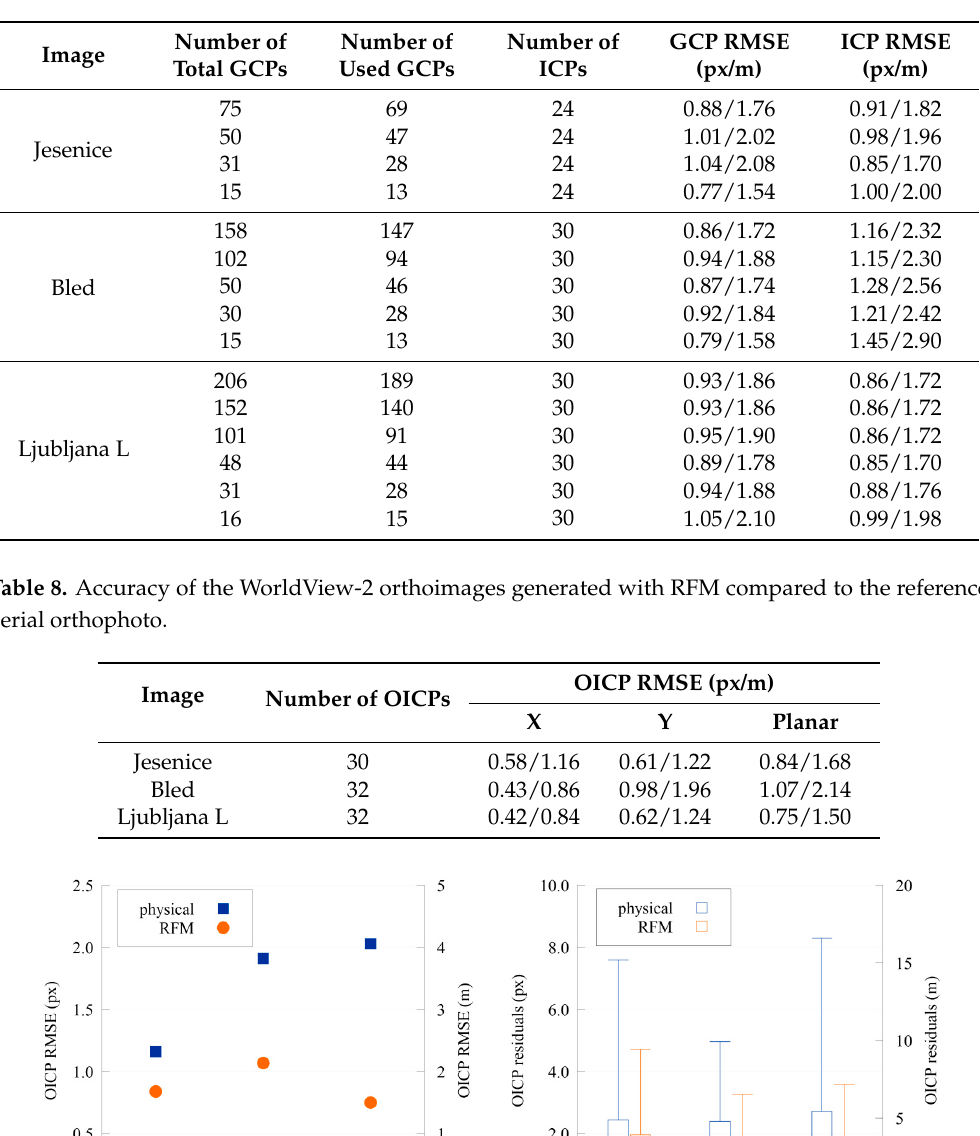
Table 7. Accuracy of the results obtained with RFM on different subsets of automatically extracted GCPs for three multispectral WorldView-2 1B images.